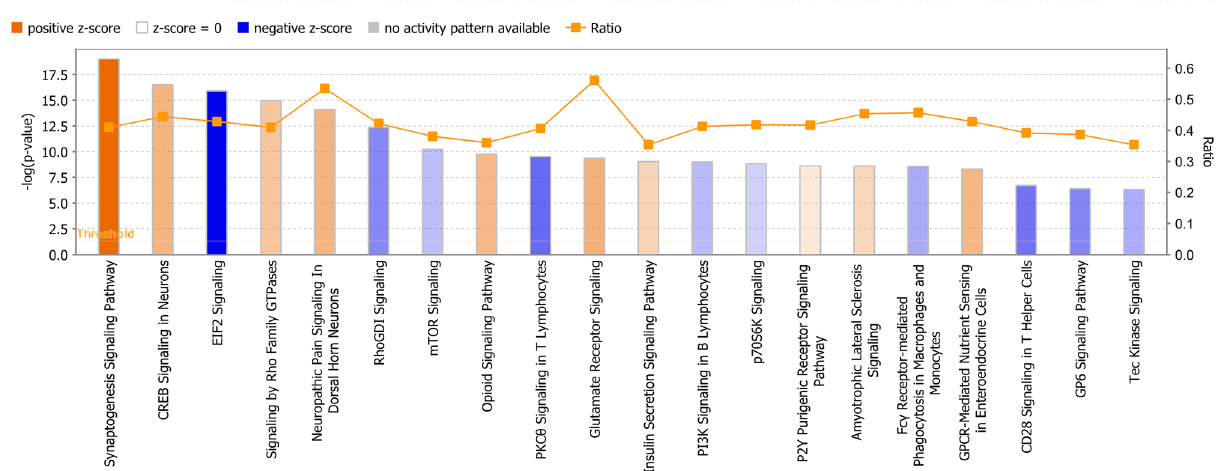
Figure 4. Top pathways of differentially expressed genes (FDR < 0.05). Pathways [Z-score > 0.05, − log ( p value) > 1.3] in orange predicted to be activated and pathways in blue predicted to be inhibited. The more intensity of the colours, the higher absolute z-score. The proportion of genes within the pathways that were differentially expressed are indicated by the orange line as ratios. The height of each bar refers to the − log